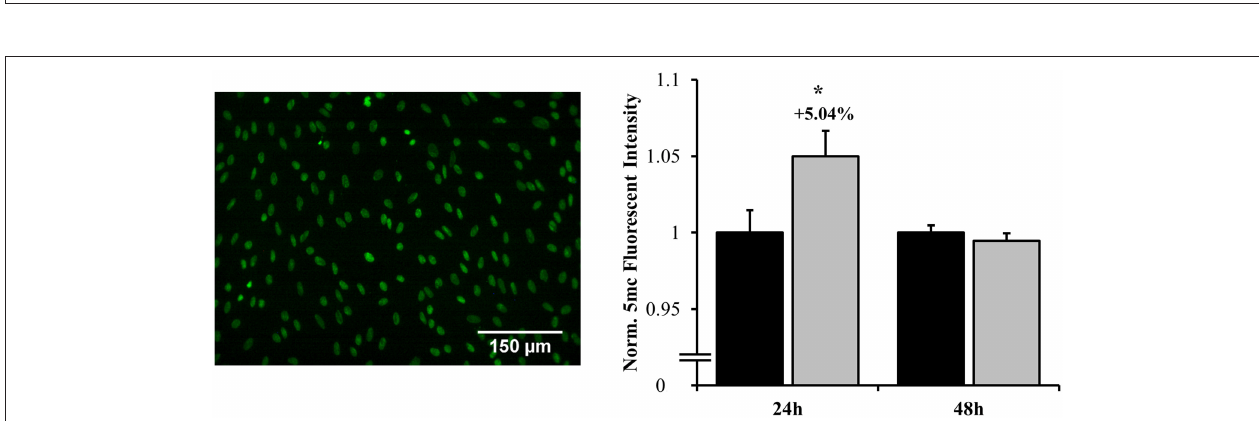
FIGURE 9 | Global DNA methylation as assessed by fluorescent labeling of 5-methylcytosine. Hypermethylation occurred at 24h post-overpressure exposure as compared to sham. No changes in methylation were observed at 48h. * p < 0.05, Data are represented as mean ± SEM, n = 10–12/group.